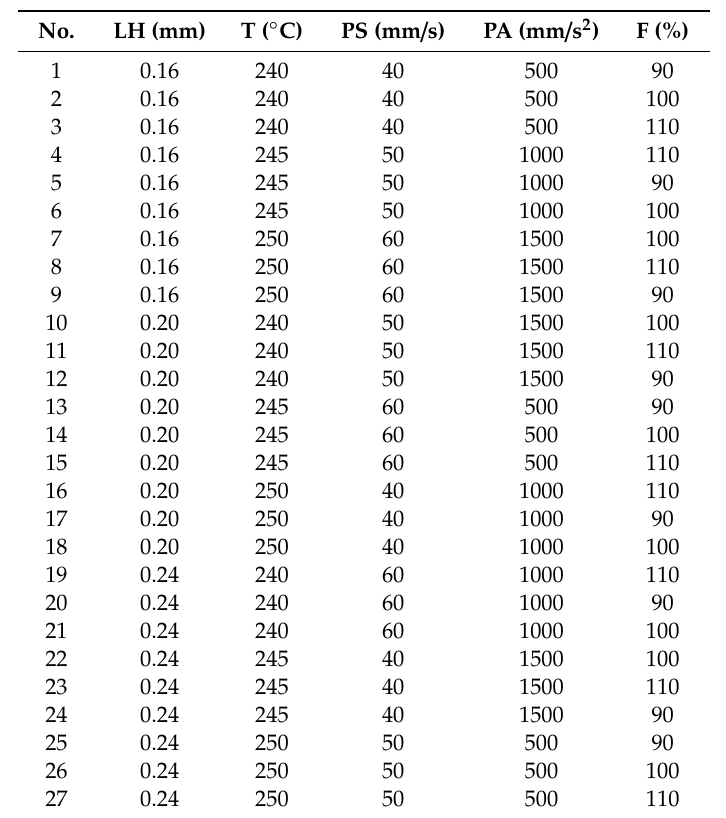
Table 2. Training dataset: design of experiment ( L 27 ), according to Taguchi method: layer height (LH), print temperature (T), print speed (PS), print acceleration (PA), and flow rate